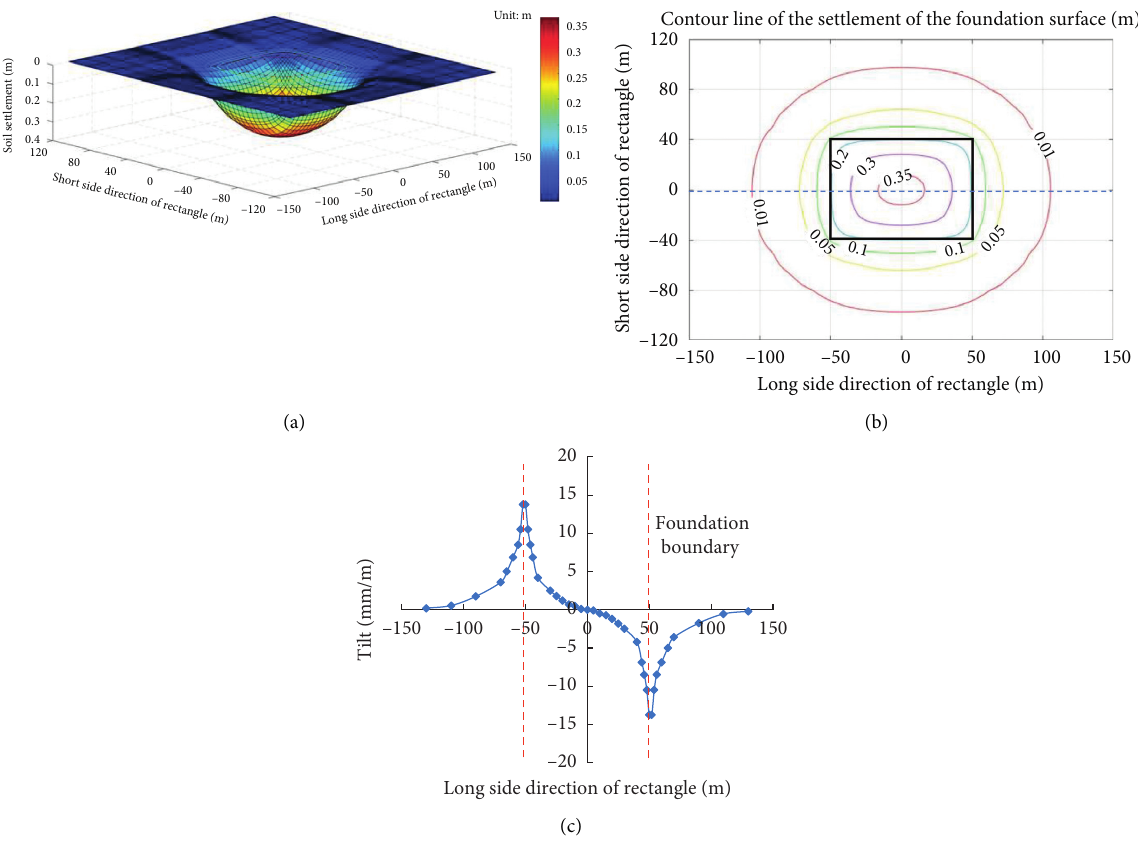
Figure 16: (a) Three-dimensional map of the settlement of the foundation surface; (b) contour line of the settlement of the foundation surface; tilt slope curve of the foundation line of the long and short sides of the rectangle. Lenght of the affected area of the gob as l A